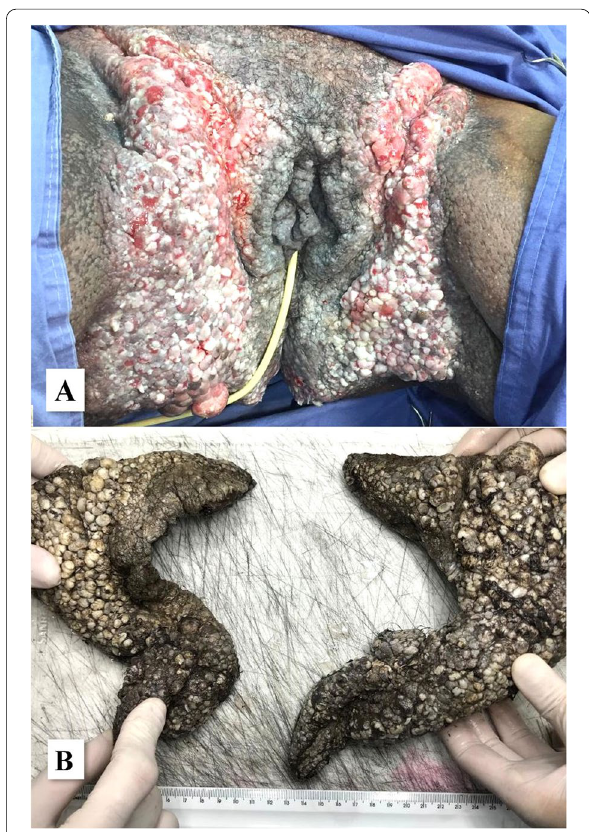
Fig. 1 Pre-operative photograph of a verruciform mass in vulva and inguinal skin ( A ). Formalin-fixed specimens ( B )